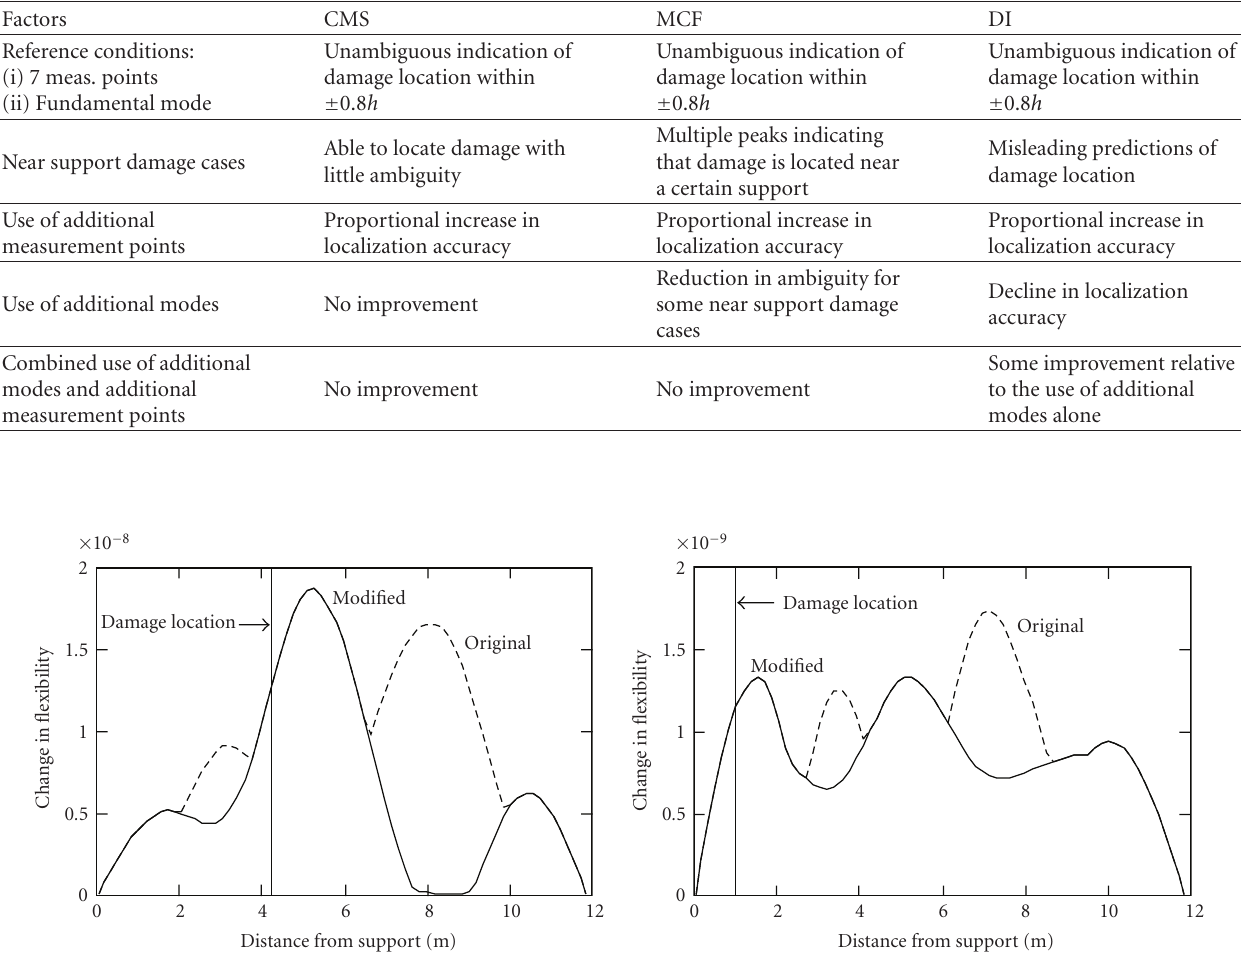
Table 6: Summary of performance of the three VBDD methods and the influence of the factors studied.